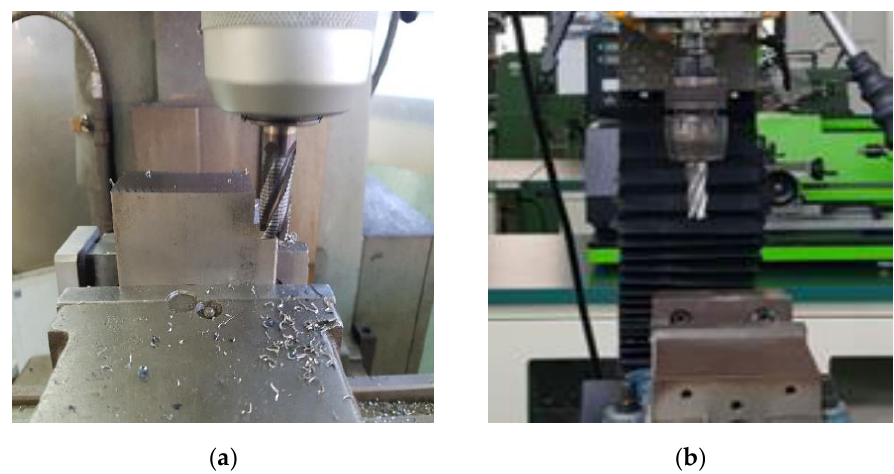
Figure 2. Experimental setup: ( a ) a drill during the active time and ( b ) a drill during the idle time.